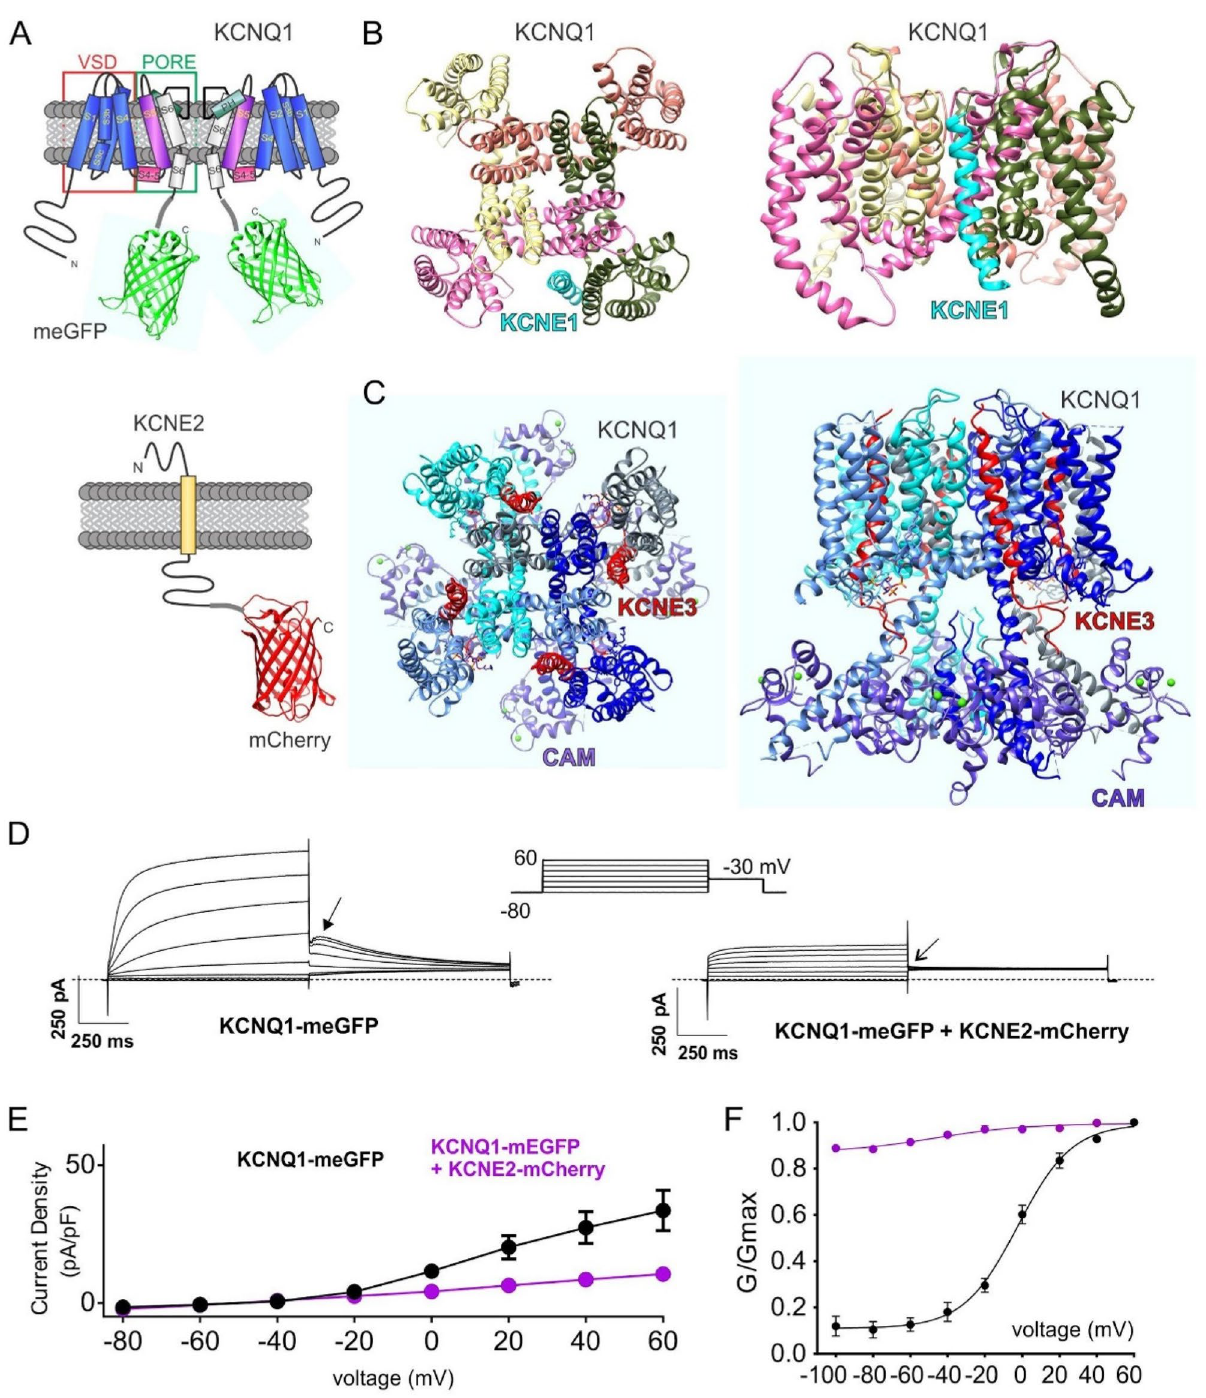
Figure 2. Fluorescent-tagged KCNQ1 and KCNQ1-KCNE2 express normal currents. ( A ) Transmembrane topologies of KCNQ1 and KCNE2 subunits showing fluorescent protein tagging of the cytosolic domains. ( B ) Extracellular (left) and intramembrane (right) views of structural model of KCNQ1-KCNE1 complex5. ( C) Extracellular (left) and intramembrane (right) views of cryo-electron microscopy-resolved structure of KCNQ1- PIP2-KCNE3-calmodulin complex8. CAM = calmodulin. ( D ) Exemplary traces showing whole-cell patch-clamp recordings from CHO cells transfected with the subunit combinations shown. Dotted line indicates zero current level. Upper inset shows the voltage protocol. Arrows indicate tail current features. ( E ) Mean pre-pulse current density ± SEM for currents expressed by KCNQ1-meGFP alone (black) (n = 14) or with KCNE2-mCherry (purple) (n = 12). ( F ) Mean G/G max relationship ± SEM measured from tail currents at arrows in panel D for currents expressed by KCNQ1-meGFP alone (black) (n = 14) or with KCNE2-mCherry (purple) (n =